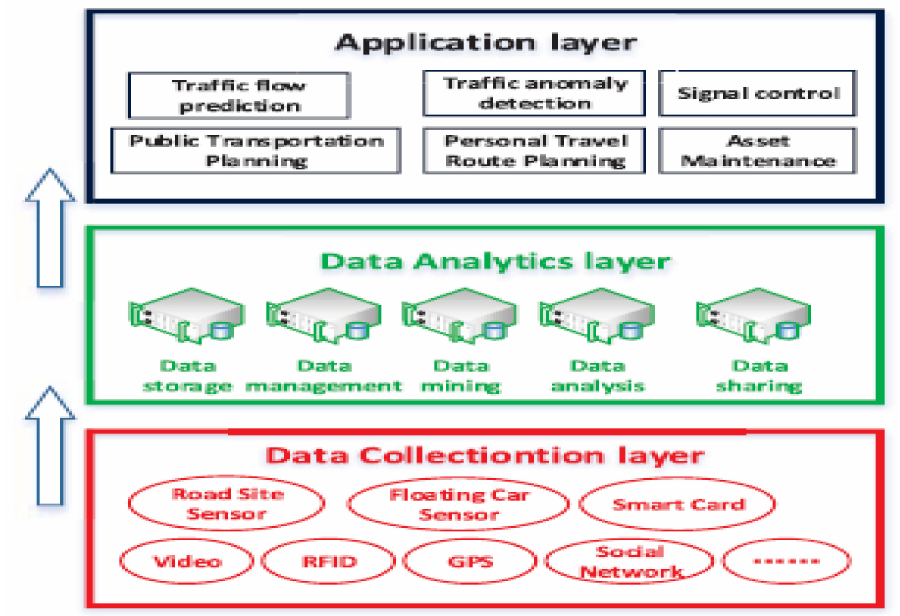
Figure 18. Three layered architectures for big data analytics